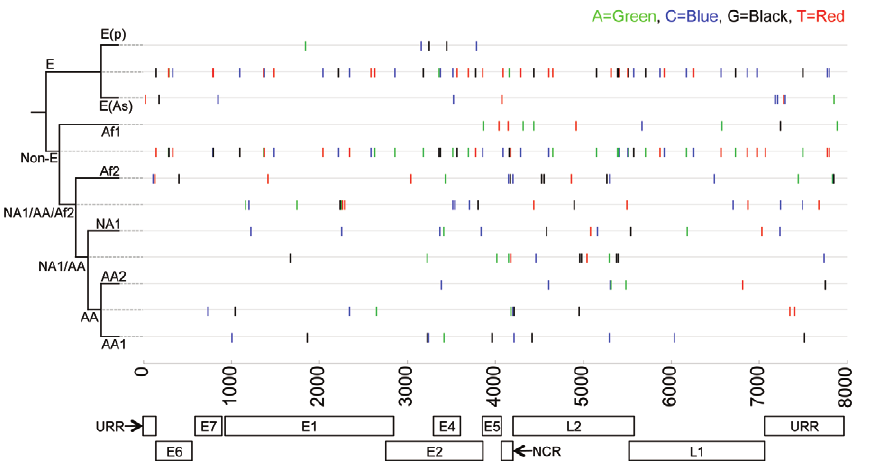
Figure 3. Lineage-specific single nucleotide polymorphisms (SNPs) in HPV16 variants and their position in the genome. Lineage- specific SNPs were determined from an alignment of the 62 complete-genome nucleotide sequences by selecting the nucleotides that occurred only in members of a given lineage. The value of each SNP is color-coded as shown at the top right of the figure. The SNPs are plotted by position in the HPV16 genome on the x -axis and aligned according to lineage in the phylogenetic tree on the y -axis. SNPs for a given lineage are cumulative as the tree is traversed from deepest node out to branches. Thus, for example, HPV16 genomes of Af-2 lineage (row 6) contain all SNPs shown on the Non-E (row 5), AA/NA1/Af-2 (row 7) and Af-2 (row 6) lines. Regions of the genome are displayed below the x -axis for reference.